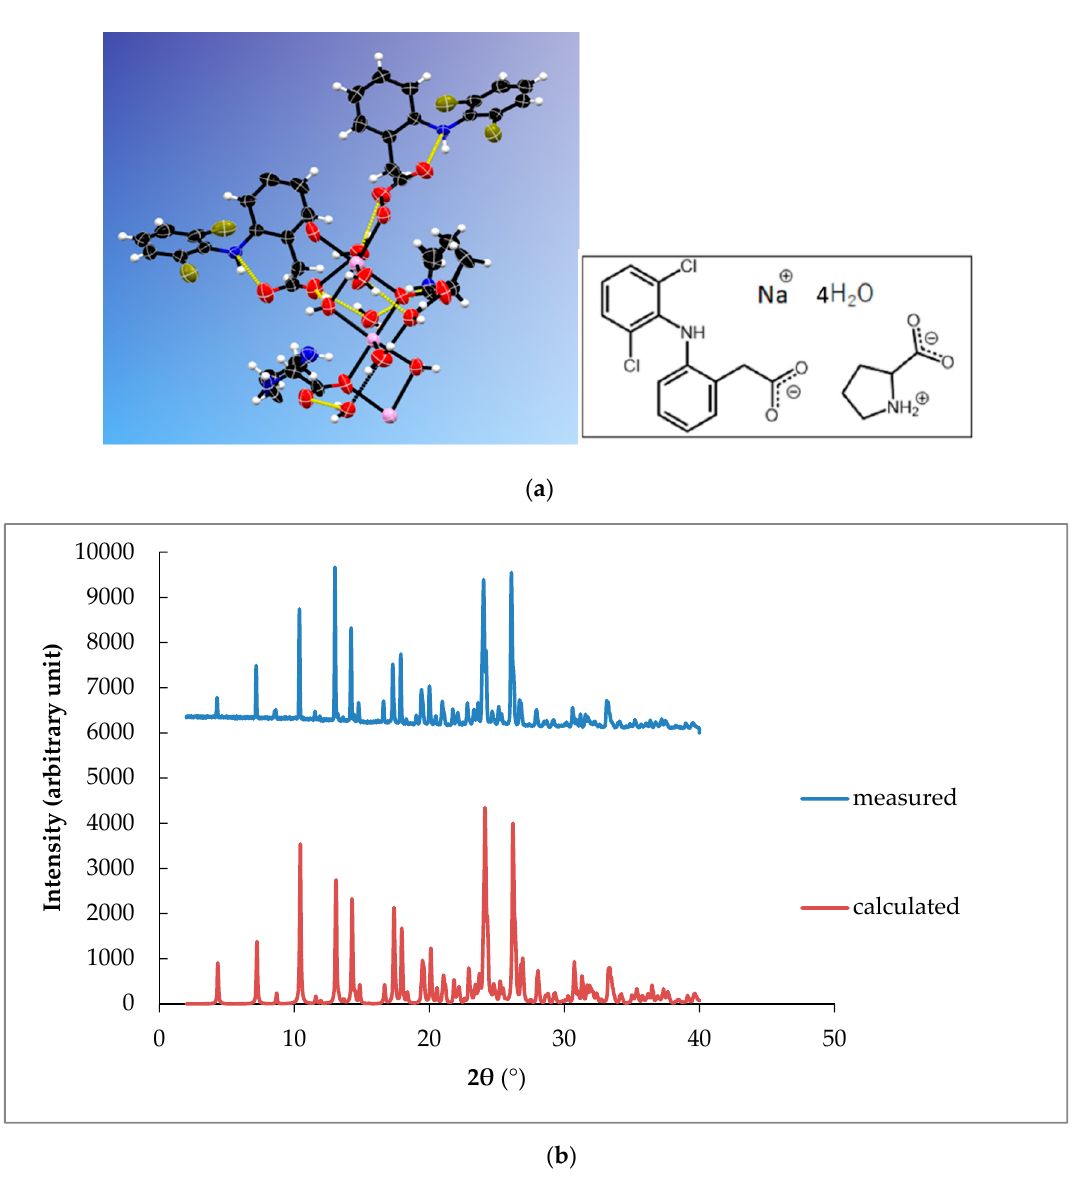
Figure 6. ( a ) ORTEP cell view and molecular structure graph of NDPT; Na + is in violet. ( b ) The measured and calculated diffractograms of NDPT.